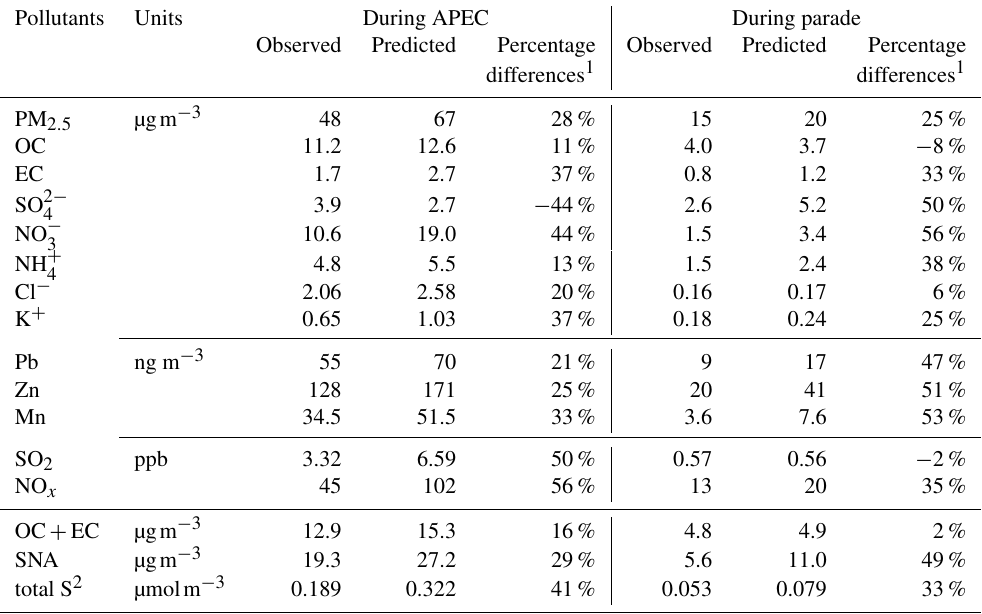
Table 9. The percentage differences between the observed and GLM-predicted concentrations of the air pollutants during APEC and the Victory Parade. Pollutants Units During APEC During parade Observed Predicted Percentage Observed Predicted Percentage differences 1 differences